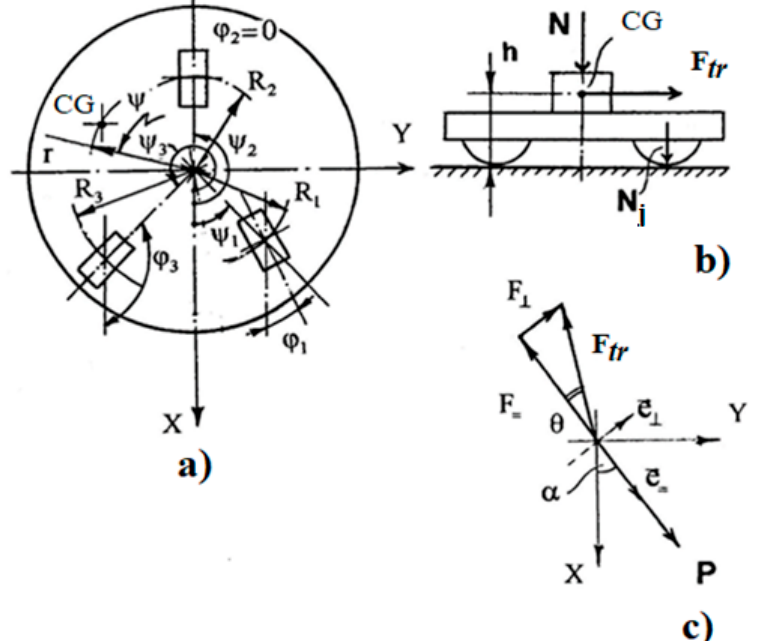
Figure 2. Calculation scheme of the mechanical model of anisotropic friction: ( a ) geometric parameters for calculation; ( b ) the scheme of application of forces; ( c ) power scheme, reduced to the center of gravity of the CG.